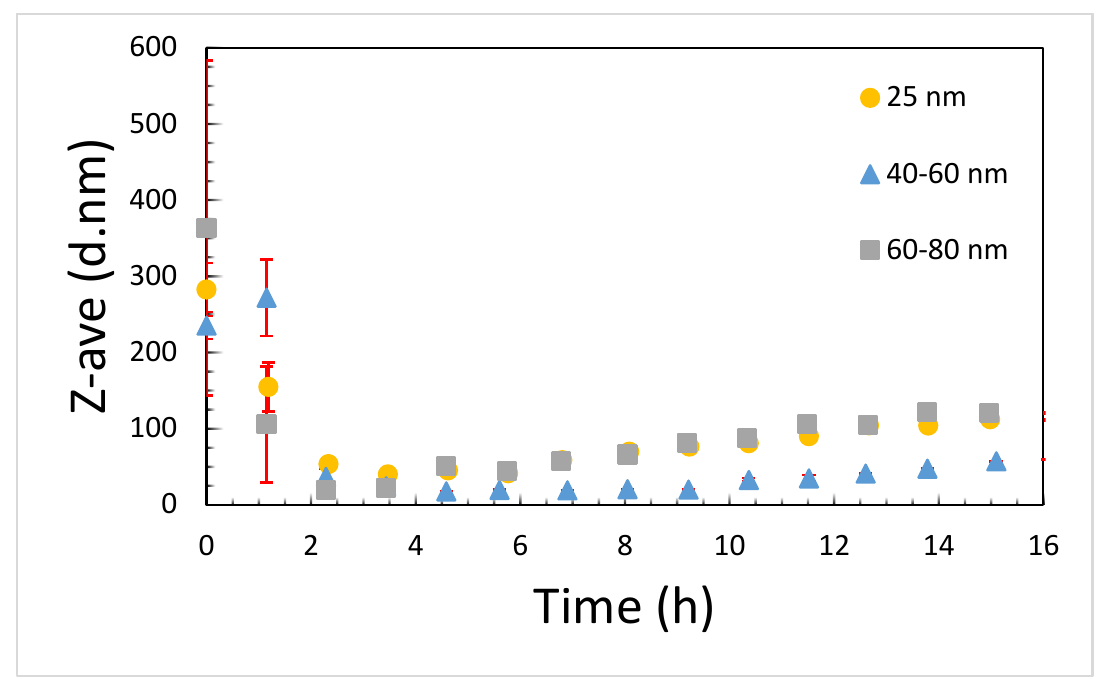
Figure 3. The Z-average diameter of 10 min bath-sonicated 20 µg/mL CuNP suspensions in media over a 16 h period with measurements made approximately every hour. After 16 h, no changes were observed out to 48 h.